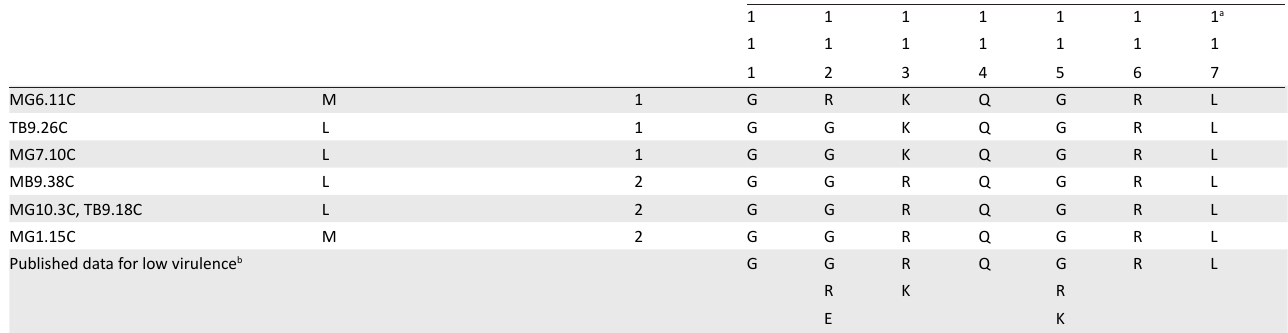
TABLE 2: Protein signatures of the F gene cleavage site of Newcastle disease virus compared to published cleavage sites of slightly virulent and virulent Newcastle disease virus. Isolate Virulence prediction by